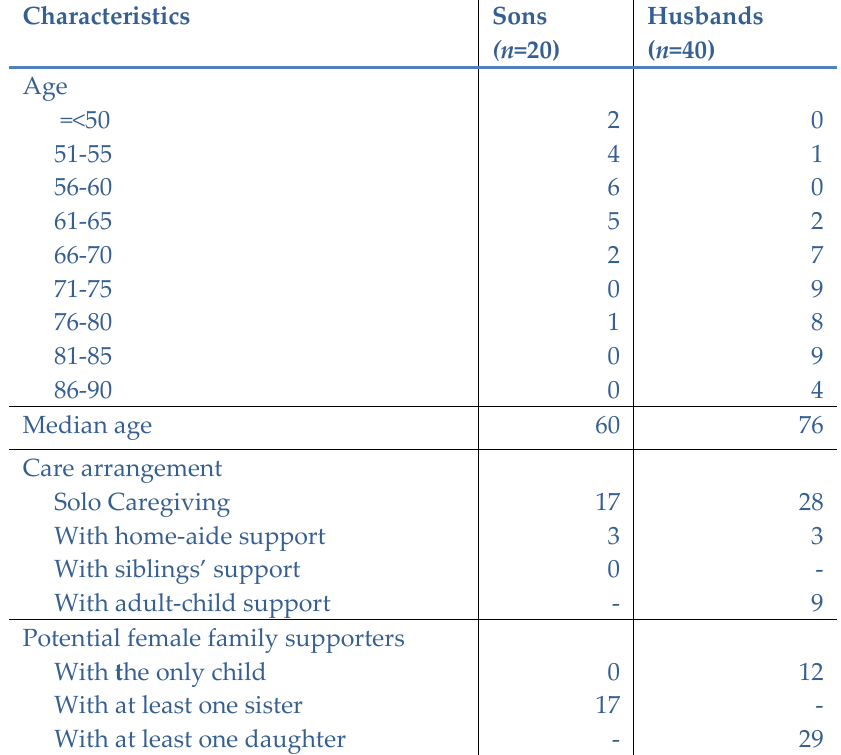
Table 1 Characteristics of Male Caregivers